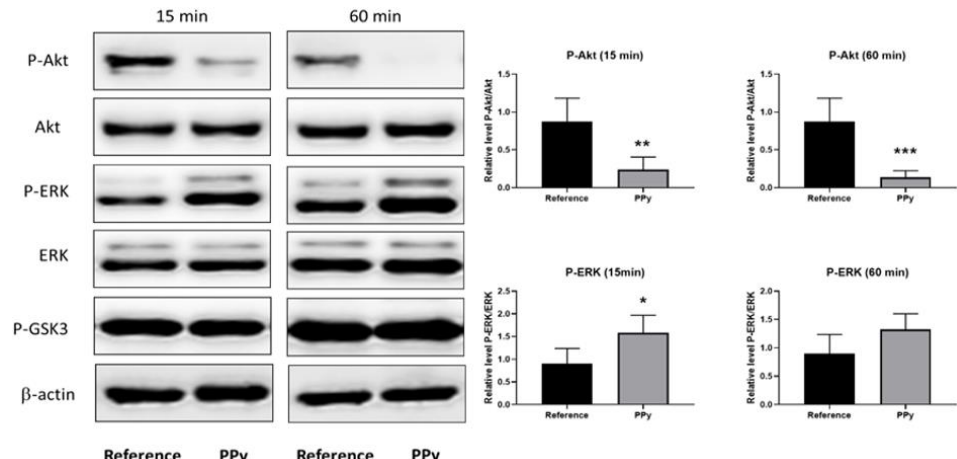
Figure 7. PPy extract inhibits Akt kinase phosphorylation. ESCs were either exposed or not exposed (reference) to 10% PPy extract (PPy) for 15 and 60 min. The levels of active, phosphorylated forms of Akt, ERK and GSK3 kinases, and the level of β-actin were determined by Western blot techniques. The level of β-actin was used as a control of protein loading. Representative Western blot and quantified data from four independent experiments are shown. Statistical significance was determined by t -test; * p < 0.05; ** p < 0.01; *** p < 0.001.